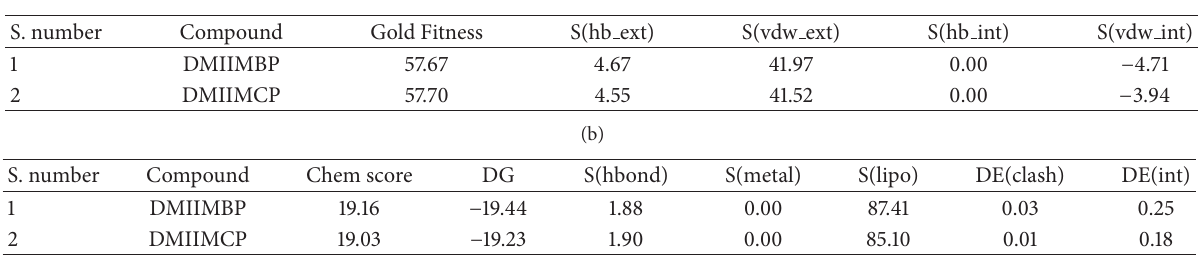
Table 5: (a) Gold Fitness values of the ligands DMIIMBP and DMIIMCP. (b) Chem score values of the ligands DMIIMBP and DMIIMCP.